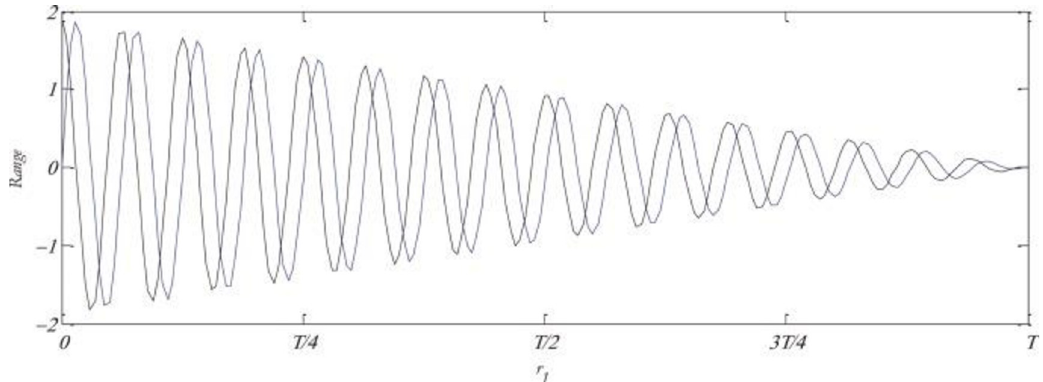
Fig 2. The decreasing pattern of Sine-Cosine indicating a switch from exploration to exploitation in the search space [71].